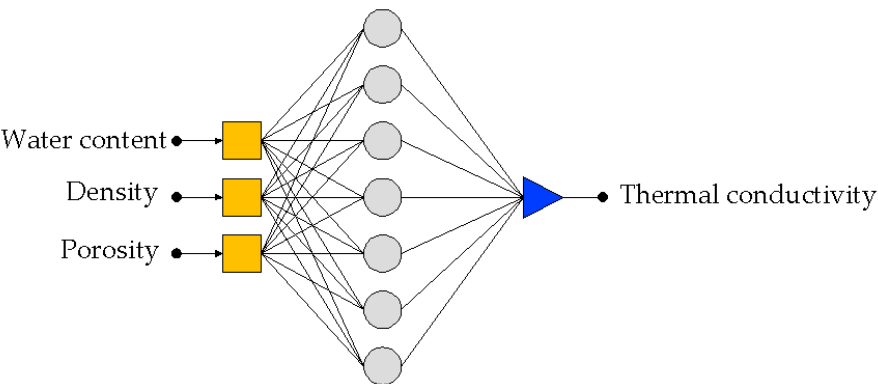
Figure 9. Network architecture of the artificial neural network (ANN) model for predicting thermal conductivity.